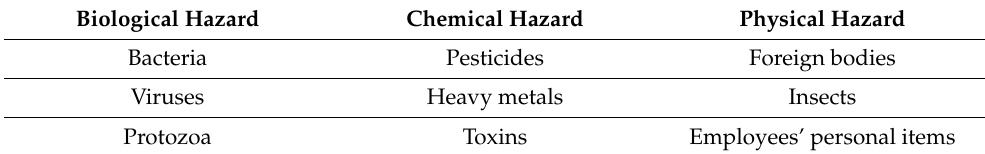
Table 1. Examples of biological, chemical, and physical hazards in the food